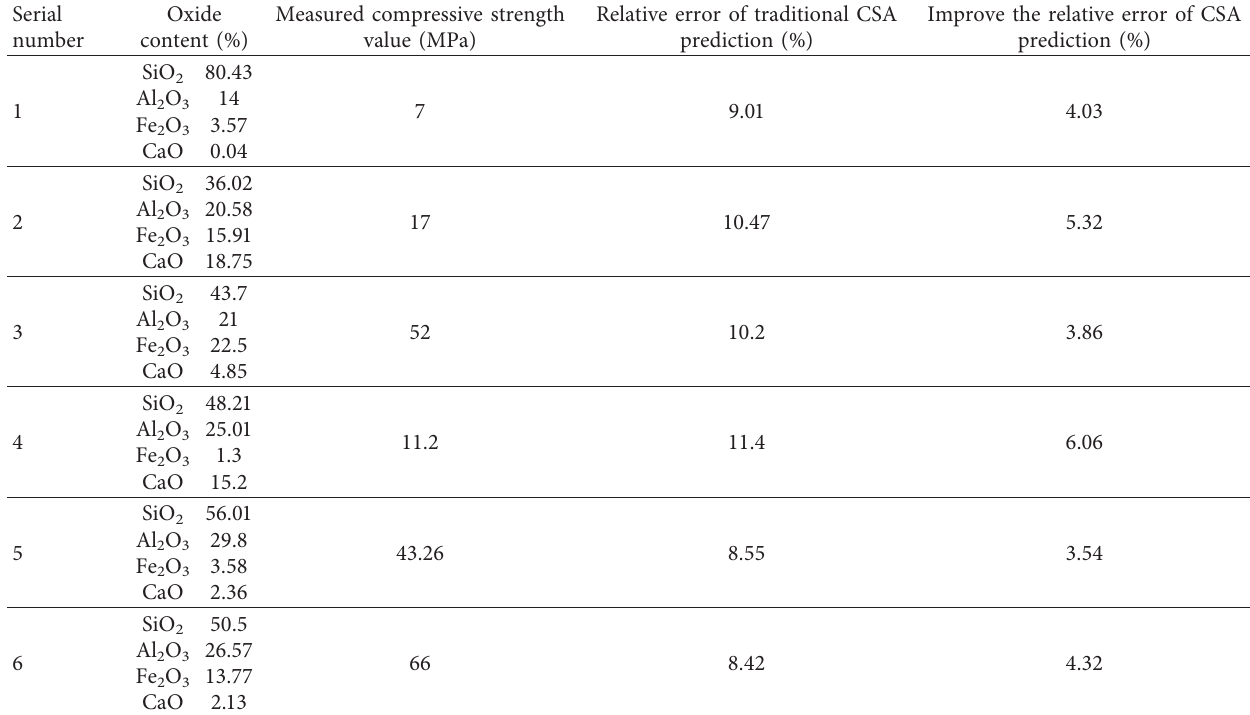
Table 8: Comparison of 7d compressive strength relative error for different oxide